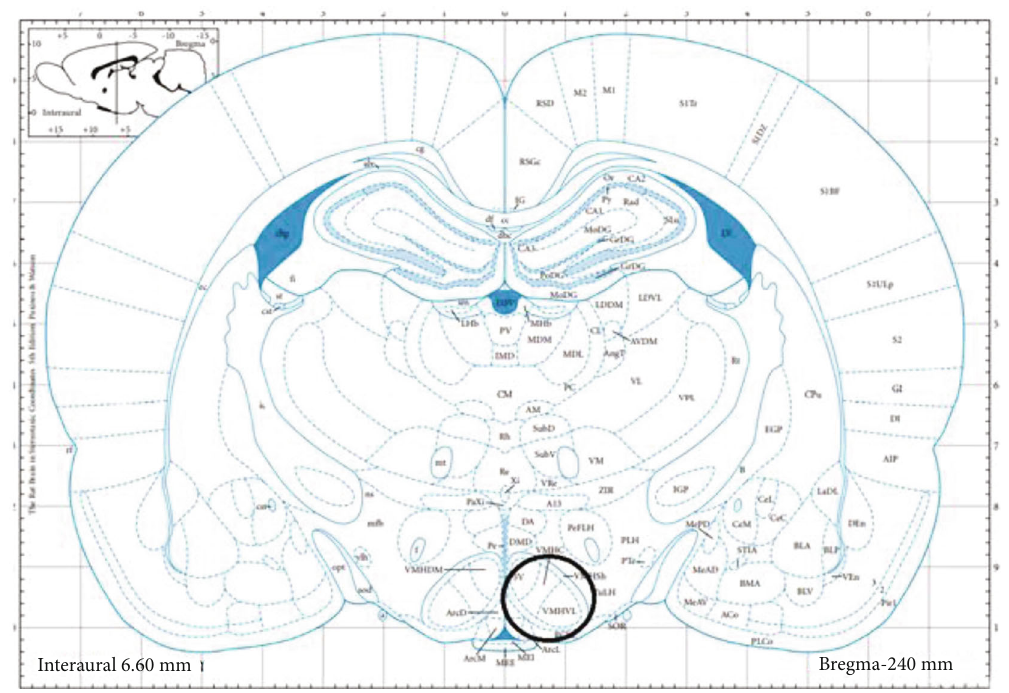
Figure 2: Schematic representation of the brain region (black circle) obtained for immunohistochemical studies. Sections 2.04 and 3.0mm posterior to Bregma. VMHC: ventromedial hypothalamic nucleus, central part; VMHVL: ventromedial hypothalamic nucleus, ventrolateral part (from Paxinos G, Watson C: The Rat Brain in Stereotactic Coordinates, ed 2. Sydney: Academic Press,